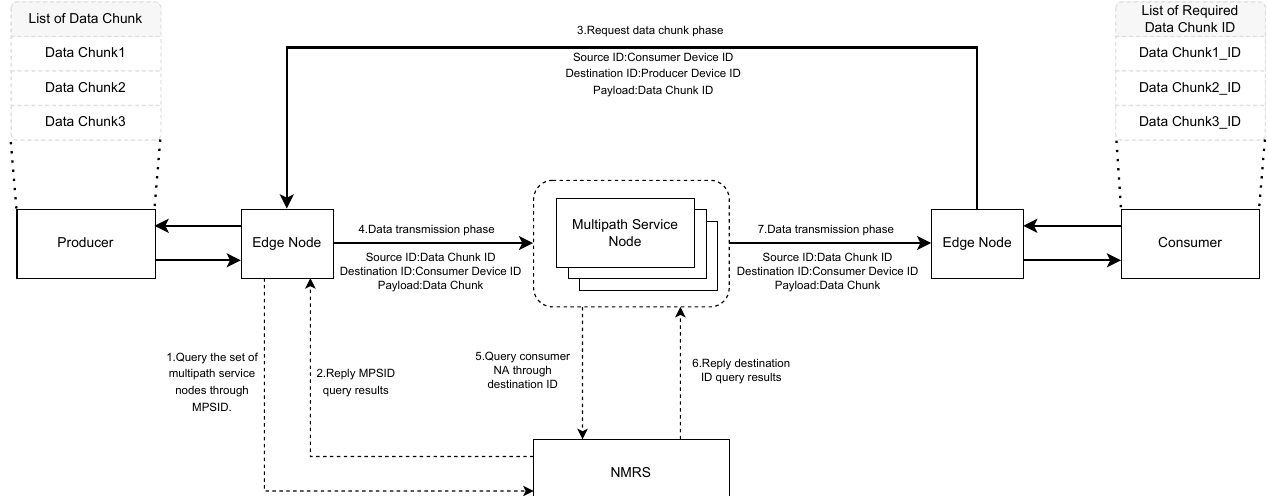
Figure 3. ID-based multipath transmission service